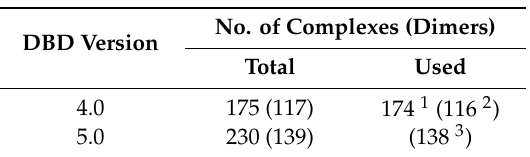
Table 5. Numbers of complexes and dimers in DBD 4.0 and 5.0.